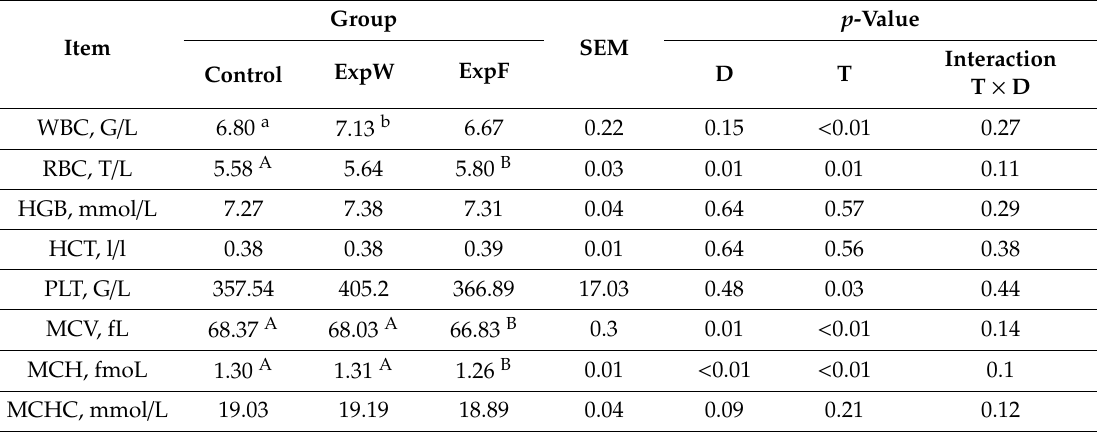
Table 3. Mean values of hematological parameters in rabbit